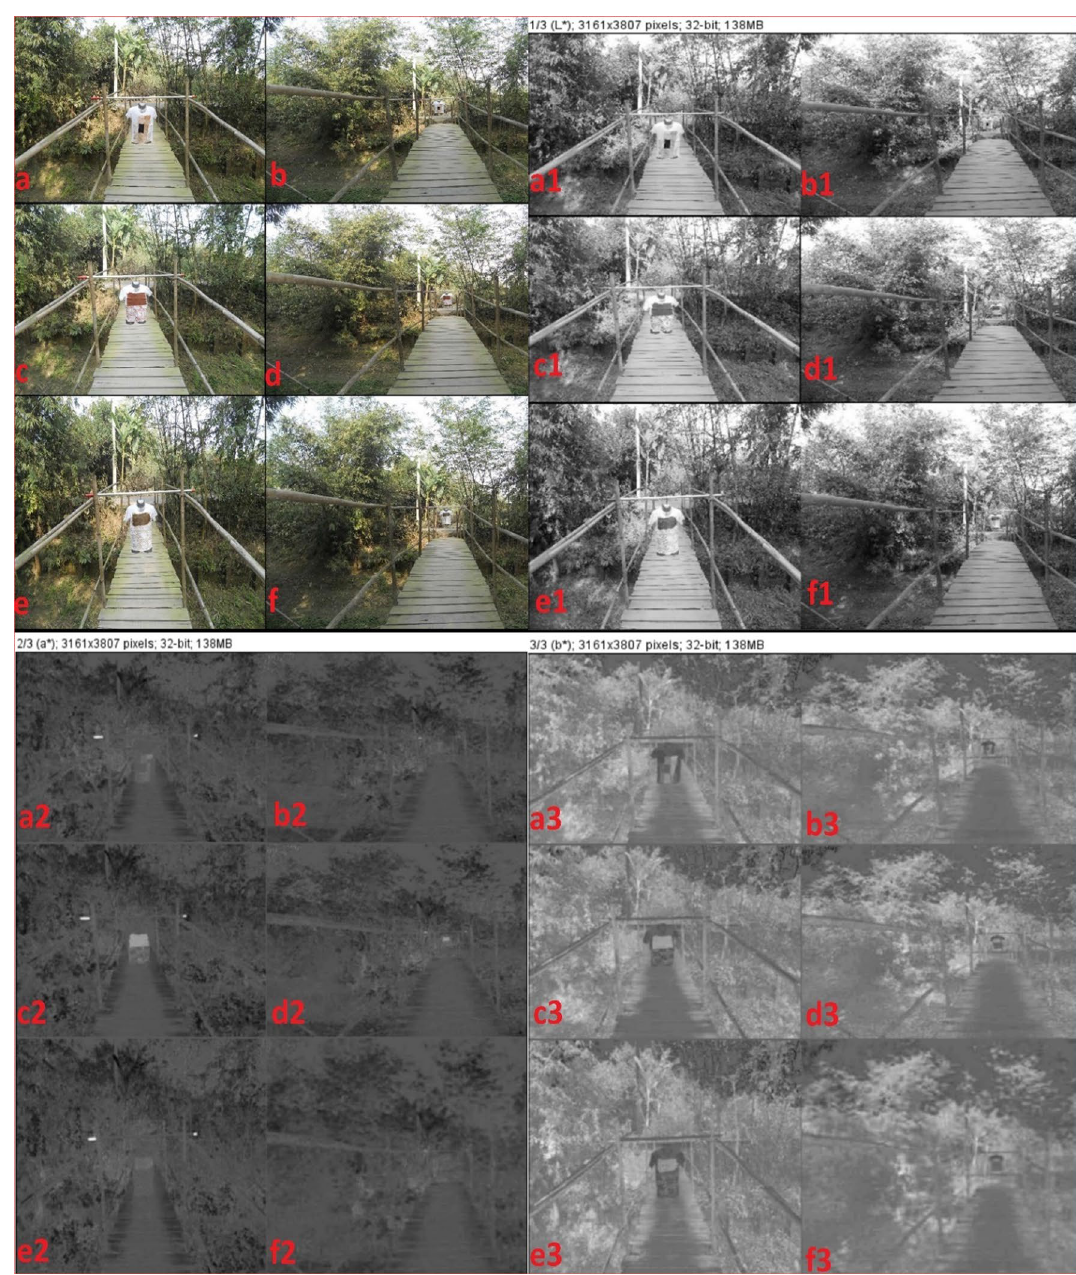
Figure 10. NPND-dyed-coated-printed garments placed against woodland CB and wooden bridge; and shown the photometric versus colorimetric views of L* ( a1 – f1 ), a* ( a2 – f2 ), b* ( a3 – f3 ) in grey scale imaging of RGB raw image ( a – f ) when the pictorial mapping has been engendered as a1 = a2 = a3 = a4; b1 = b2 = b3 = b4; c1 = c2 = c3 = c4; d1 = d2 = d3 = d4; e1 = e2 = e3 = e4; f1 = f2 = f3 = f4 for chromatic Chromatic analysis of L*, a*, b*, RGB of NPND-dyed-coated-printed garments against com- bat backgrounds. Figure 12A, CIE L*, a*, b* values of NPND-coated-printed textiles are more symmetrical with CB materials in general rather than NPND-dyed textiles due to chromatic matching between treated textiles and CB materials. There are also exceptions of symmetric matching of L*, a*, b* for colorful dyed fabric such as Swietenia Macrophylla , Mangifera Indica , Terminala Arjuna , Camellia Sinensis and Acacia Acuminata . L* value of Corchorus Capsularis and Cinnamomum Tamala are comparatively higher due to lower interactions of dye-fibre and mordant free coloration in NPND-dyebath. L*, a*, b* values of Swietenia Macrophylla and Corchorus Cap- sularis coated fabric are exceptionally matching against woodland CB of Shorea Robusta Gaertn (green leaves) and Bamboo Vulgaris (green leaves). L* value of Swietenia Macrophylla dyed fabric is comparatively lower due to NPND-mordanting of Areca Catechu and comparatively higher dye-fibre interactions in NPND-dyebath 18 . Figure 12B, similarly CIE trichromatic intensity of Swietenia Macrophylla and Corchorus Capsularis coated fab-